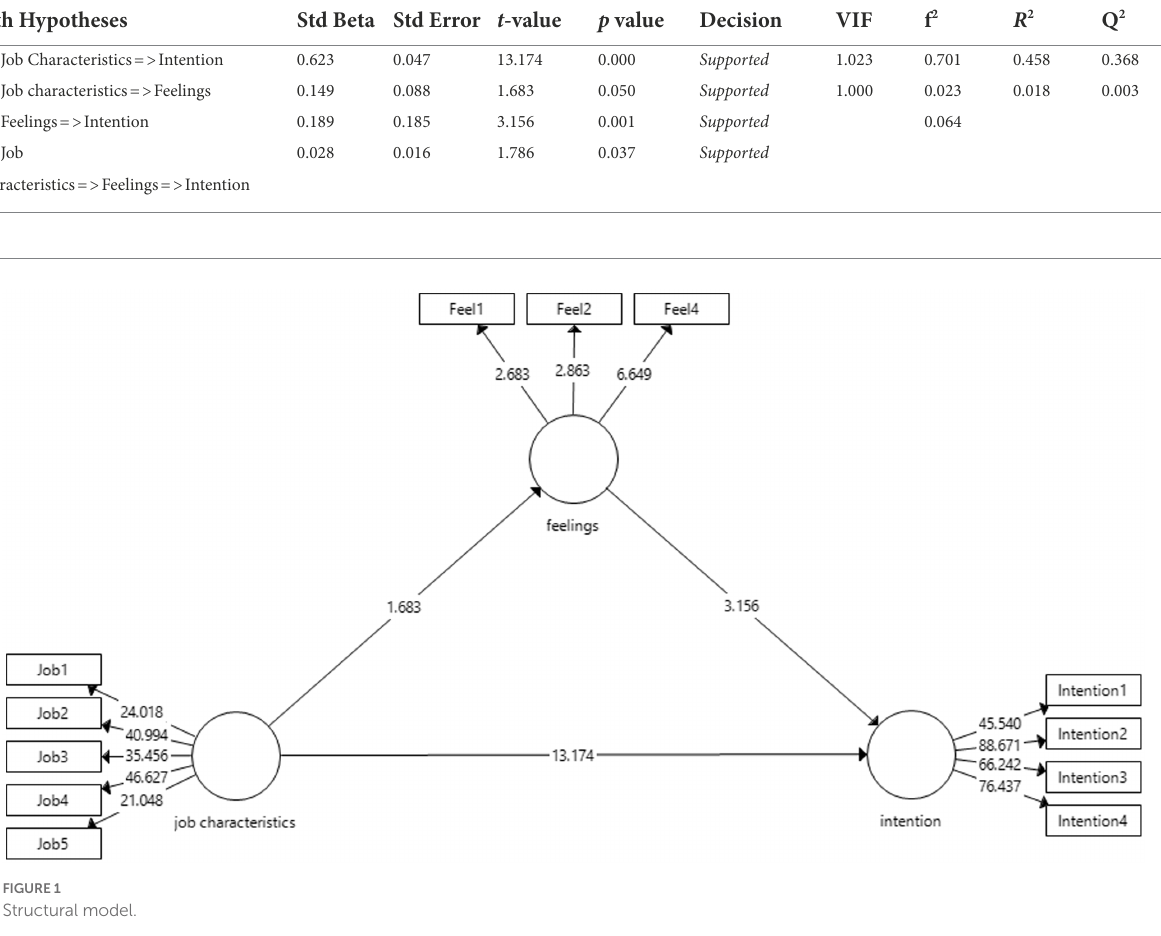
TABLE 4 Assessment of structural model.